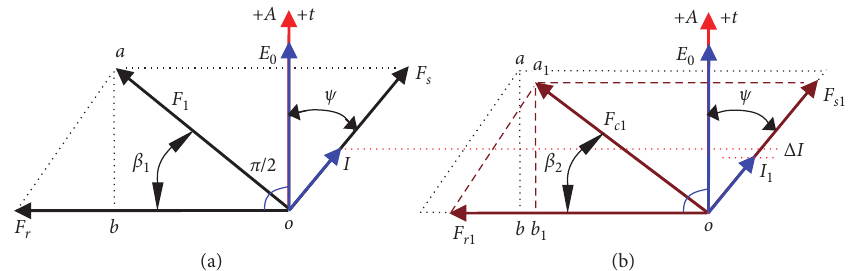
Figure 4: Diagram of MMF vectors. (a) Normal. (b)